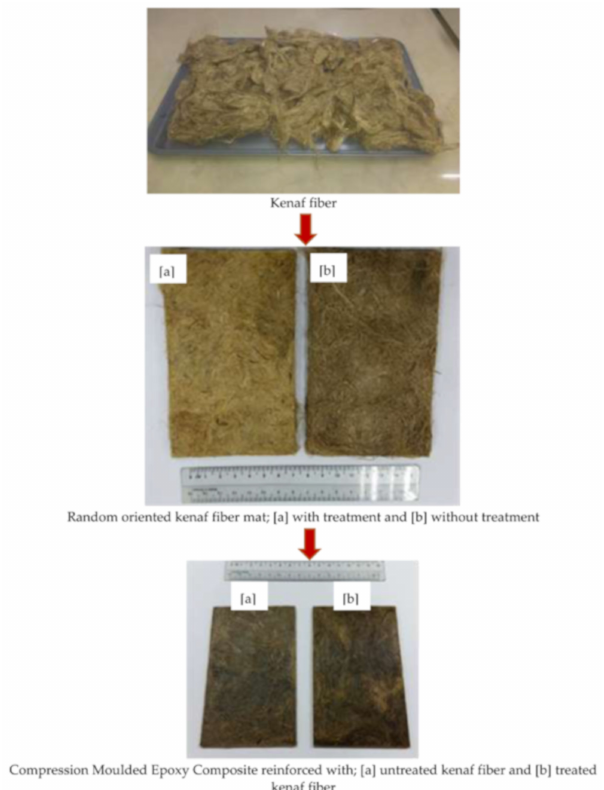
Figure 3. Compression moulded epoxy composites reinforced with untreated kenaf fiber and treated kenaf